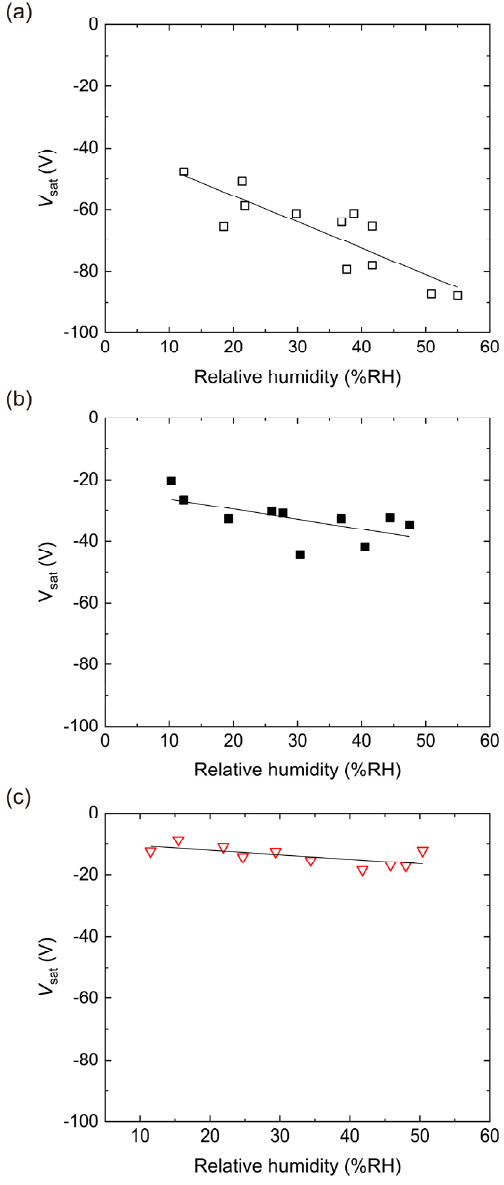
Figure 8. Plots of V sat versus relative humidity for PES films doped with 1 wt% ( a ), 5 wt% ( b ), and 10 wt% ( c ) P25 nanoparticles.